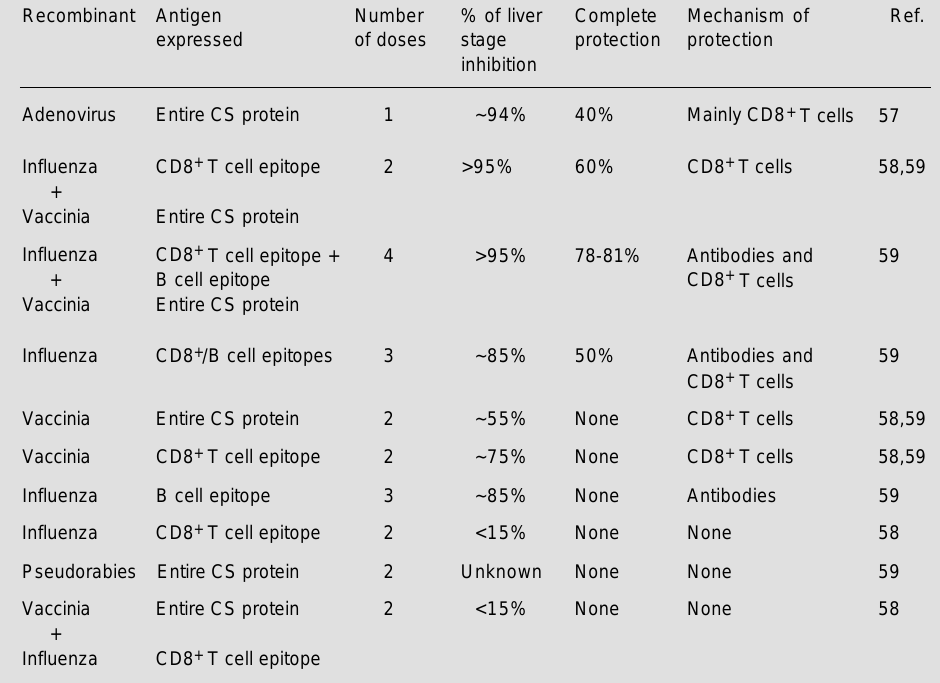
Table 2 - Summary of experiments using recombinant viruses to elicit protective immunity against pre- erythrocytic stages of Plasmodium yoelii. Recombinant